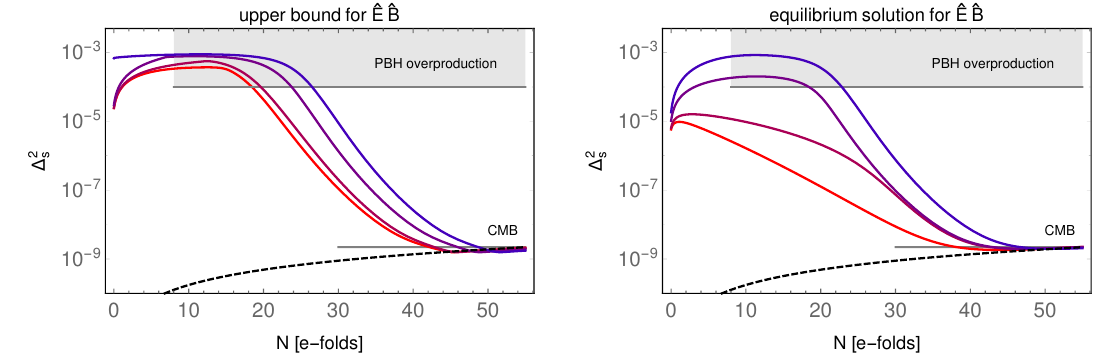
Figure 8 . Scalar power spectrum. Left panel: upper bound for ^ E ^ B . Right panel: equilibrium solution for ^ E ^ B . Color coding as in (cid:12)gure